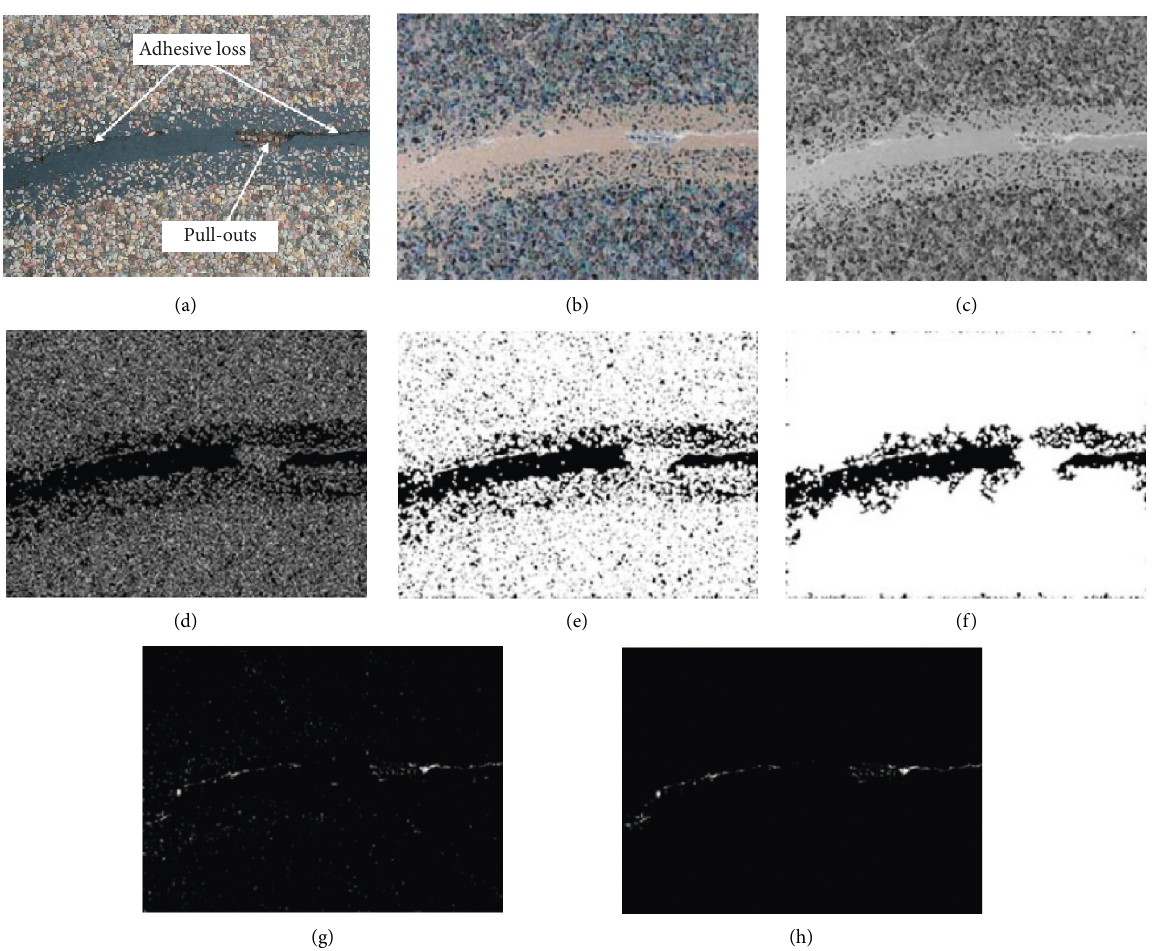
Figure 6: Crack sealing performance analysis from image processing (distress region extraction of sealed cracks) [58]. (a) Original figure. (b) Complement of image. (c) Grayscale image. (d) Binary gradient mask. (e) Dilated gradient mask. (f) Binary image with holes filled. (g) Binary image from the original figure. (h) Final extraction of the distress of a sealed crack.